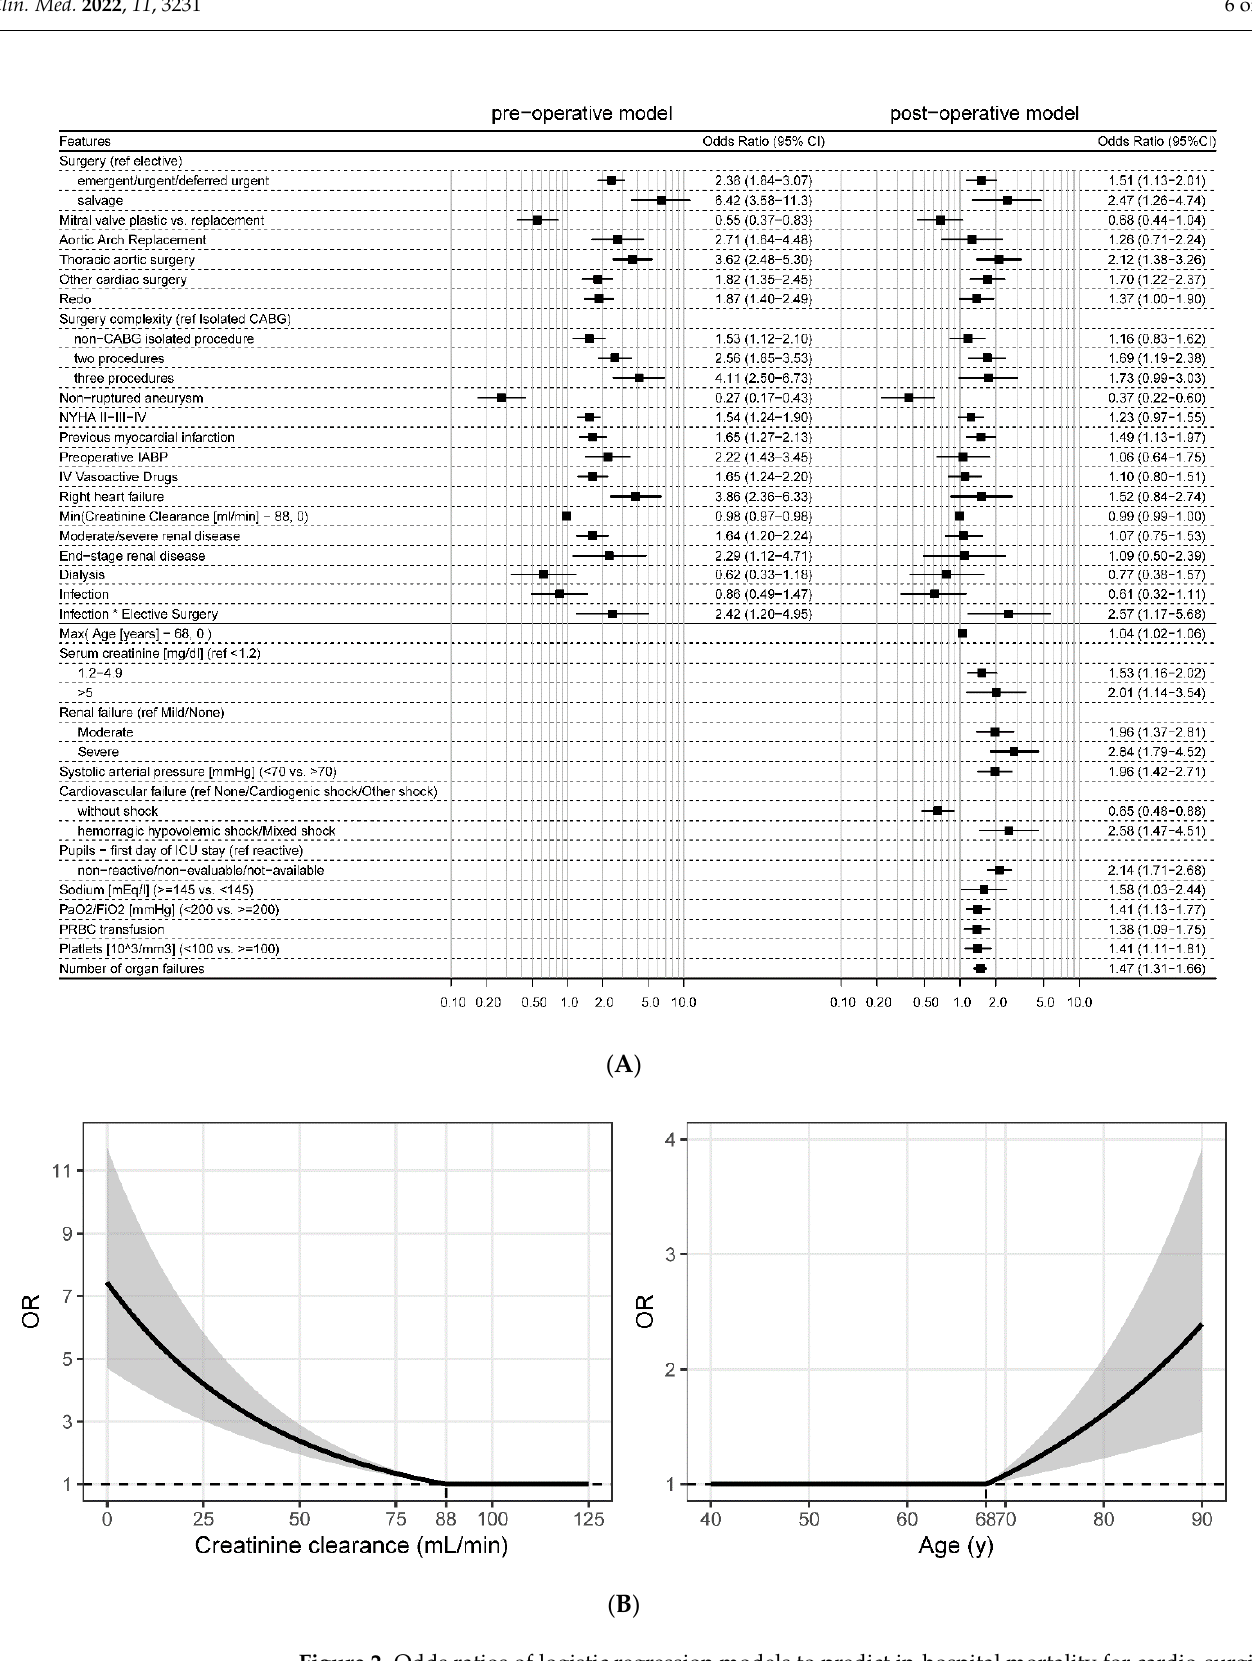
Figure 2. Odds ratios of logistic regression models to predict in-hospital mortality for cardio-surgical patients before surgical act and at ICU admission. ( A ) Forest plot summarizing ORs of multivariate pre-operative (left) and post-operative model (right); ( B ) ORs of continuous variables: creatinine clearance (left) and age (right).